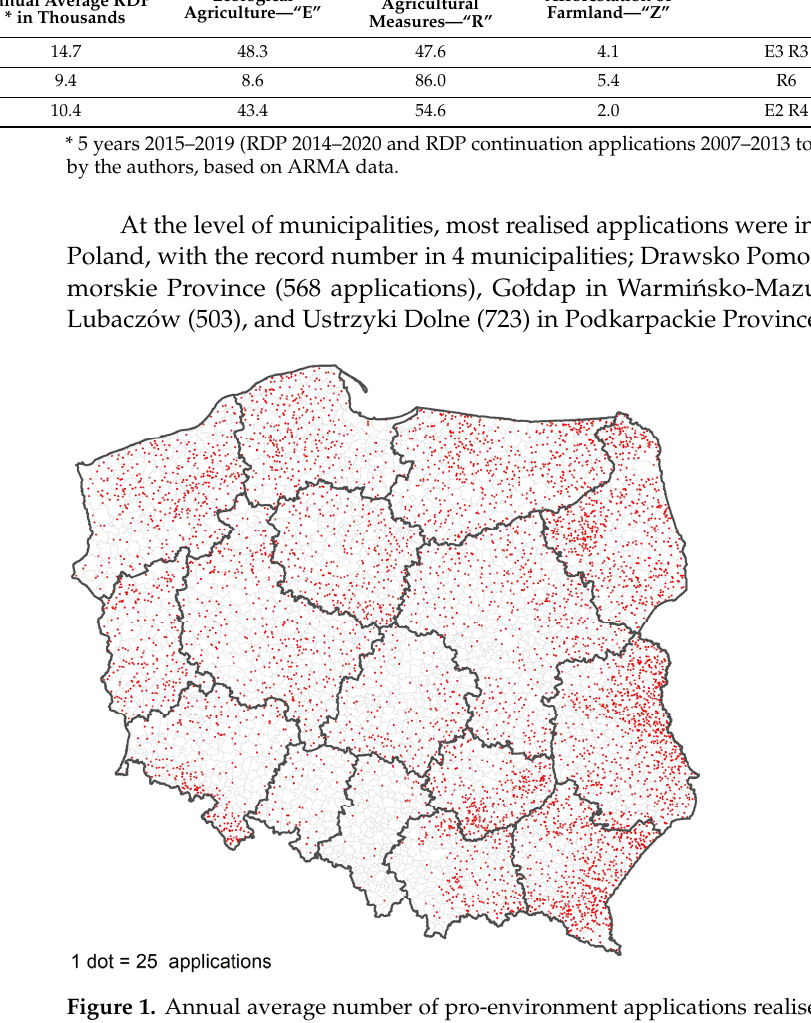
Figure 1. Annual average number of pro-environment applications realised in agricultural farms. Source: developed by the authors, based on ARMA data. In accordance with the d’Hondt method adopted here, the average combination of